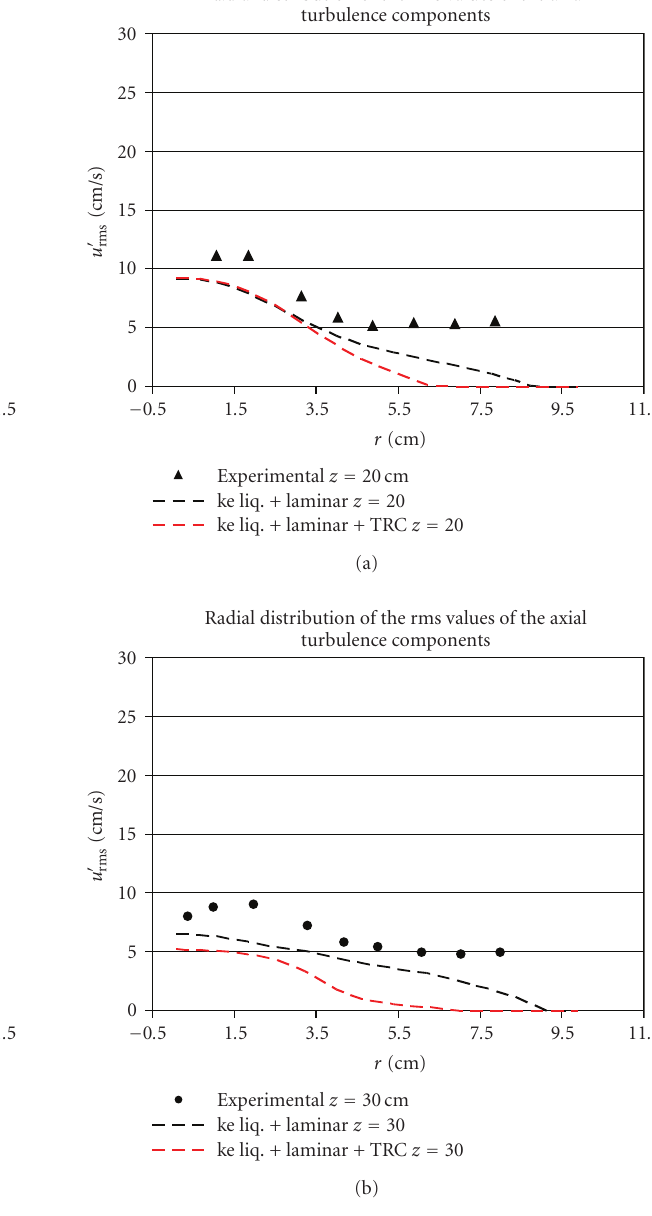
Figure 4: Radial distribution of the root-mean-square values of the axial turbulence component (TRC term sensitivity